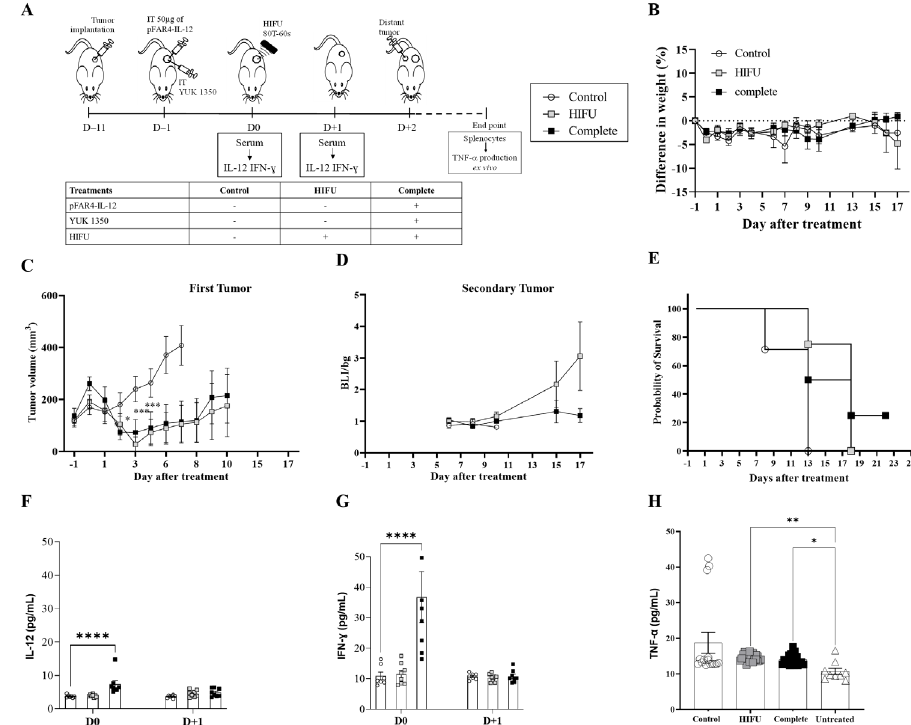
Figure 6. Evaluation of in vivo efficacy of the therapeutic strategy as regards to the distal tumor. (A) Diagram of the treatment schedule. Balb/C mice were implanted subcutaneously with CT26-Luc tumor fragment on the flank (D–11). When the tumor reached the appropriate size they were injected intratumorally with 50 µg of pFAR4-IL-12 and/or liposome containing 0.16 µmol YUK1350 (D–1). At D0, HIFU was applied in the tumor (HIFU group or complete group). At D0 and D+1 mouse sera were collected and IL-12 was quantified by ELISA. Mice were sacrificed when one tumor dimension reached more than 10 mm in one dimension or at the end of the experiment. The different groups studied are listed in the insert. (B) Mice weight as a percentage as regard to D–1. Mice body weights were monitored regularly and the percentage difference in weight was calculated as a function of the weight of each mouse at D–1 (100 × (Value-Baseline)/Baseline). (C) Tumor volume of a primary tumor in mm 3 . Tumor sizes were measured 2 days with a caliper and the volume was calculated according to the formula (Width × Width × Length/2) 2-way ANOVA statistical analysis with Dunnett’s multiple comparisons test was applied *** P < 0.001, * P < 0.05. (D) Bioluminescence ratio of the secondary tumor regarding the background. Secondary tumor was detected by bioluminescence. Mice were injected by i.p. route with 2 mg of luciferin and signal acquisition was performed with an intensified charge-coupled device (iCCD) camera for 10 min. Results are presented as BLI signals in the tumor divided by the background. (E) Evaluation of the survival rate of the animals. The Kaplan-Meier method was used for survival analysis. n = 7–8. (F, G) IL-12 IFN-γ; and measured in mouse serum; n = 5–8; bar ± SEM. Cytokine level in the mouse serum at D0 and D+1. (H) TNF-α in the supernatant of splenocytes activated with CT26 after treatment. At the end of each in vivo experiment, the splenocytes were collected from sacrificed mice and cocultured with CT26- Luc tumor cells for 48 h. TNF-α secreted in the supernatant was quantified by ELISA. ** P ≤ 0.01; *** P ≤ 0.001; **** P ≤